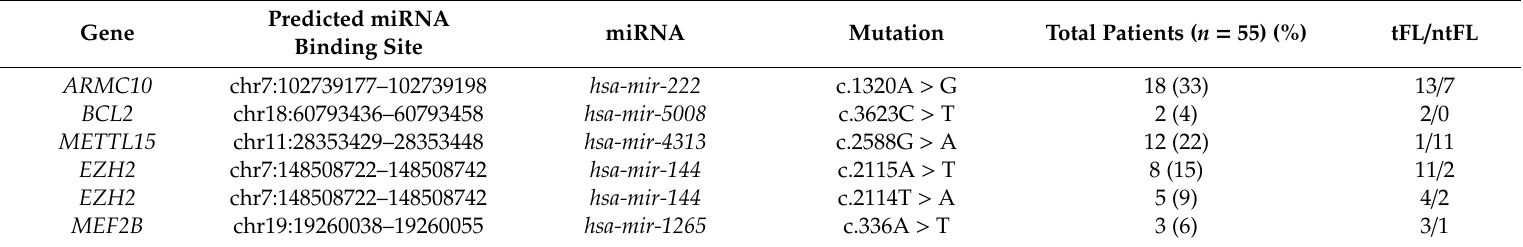
Table 2. Selected candidate genes for functional